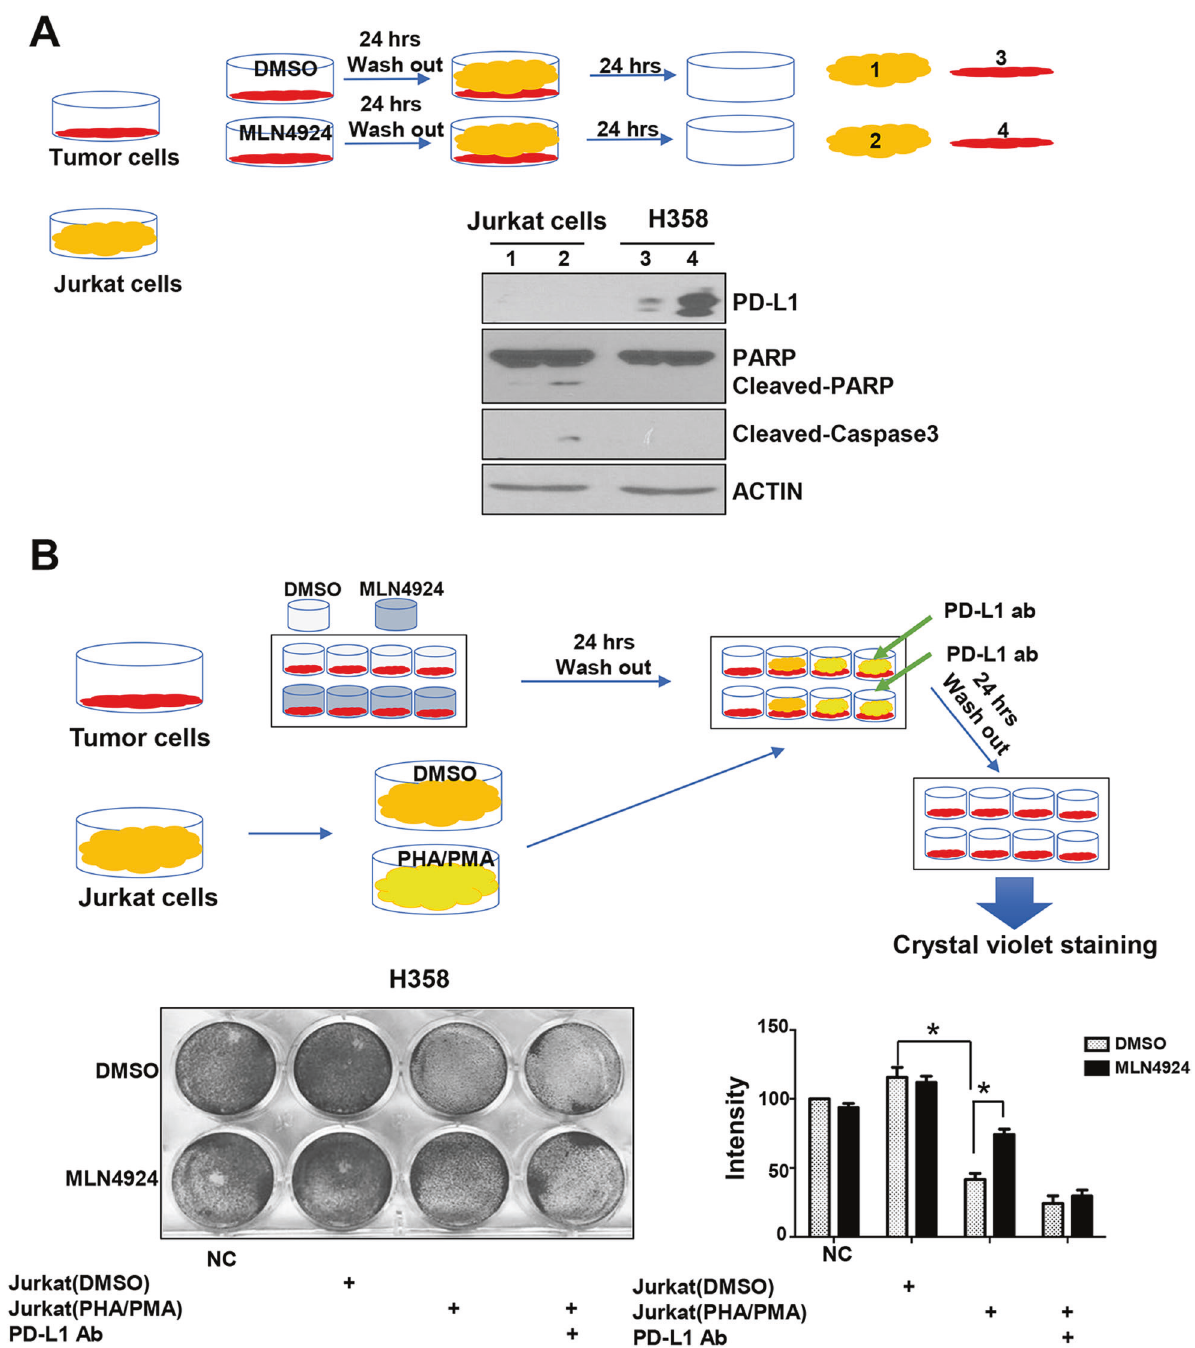
Fig. 4 MLN4924 attenuates cytotoxic effect of Jurkat cells through PD-L1 induction. A Jurkat cells co-cultured with MLN4924-pretreated cancer cells underwent apoptosis. Sub-con fl uent H358 cells were treated with MLN4924 (0.5 μ M) for 24 h. After medial removal and PBS washing, suspension of Jurkat cells was added and cultured for 24 h. H358 and Jurkat cells were then harvested, separately, for IB with the indicated Abs. B MLN4924-pretreated cancer cells became resistant to the killing by activated Jurkat cells. H358 cells were treated with MLN4924 (0.5 μ M) for 24 h, co-cultured with PHA/PMA-activated Jurkat cells with or without anti-PD-L1 antibody (PD-L1 ab) for 24 h, followed by crystal violet staining of viable adhered H358 cells and photography. Shown are mean ± SEM of three independent experiments. p < 0.05 (*), p < 0.01 is a general phenomenon seen in multiple cancer cell lines derived from a variety of cancer types, likely through both neddylation- dependent (ubiquitylation and degradation) and independent gulating PD-L1 expression in glioma cells [9, 22], our current study (transcriptional activation) manners; (3) MLN4924 induction of PD- provided several lines of new fi nding: (1) PD-L1 induction can be L1 has negative impact on its anticancer activity, which can be achieved through activation of the MEK-JNK-AP1 axis by MLN4924, overcome by co-treatment with either MEK inhibitor or PD-L1 Ab. which is neddylation-independent; (2) MLN4924 induction of PD-L1